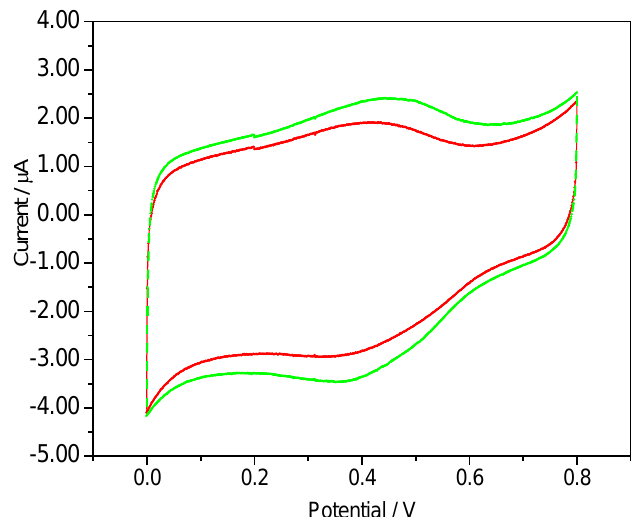
Figure 4. Cyclic Voltammogram of PAAm (red), and NanoC (green) in 1 M H 2 SO 4 , scan rate 50 mV/s, glassy carbon working electrode, Ag/AgCl reference electrode and platinum as counter-electrode. The electrochemical responses (CV at 1 mV/s) of DA and AA preloaded in on different pieces of PAAm and NanoC (from solutions of 0.25 mM at pH 7 (PBS)) were evaluated (Figure 5).